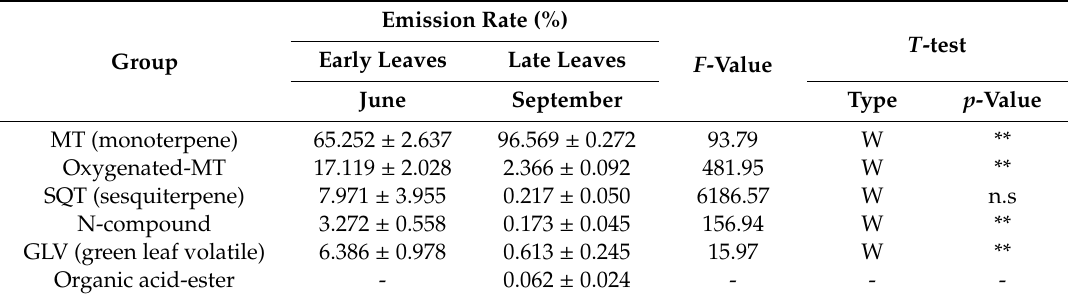
Table 2. Dominances of biogenic volatile organic compounds (BVOCs) at chemical group level. Emission Rate (%) T -test Early Leaves Late Leaves Group F -Value June September Type MT (monoterpene) 65.252 ±